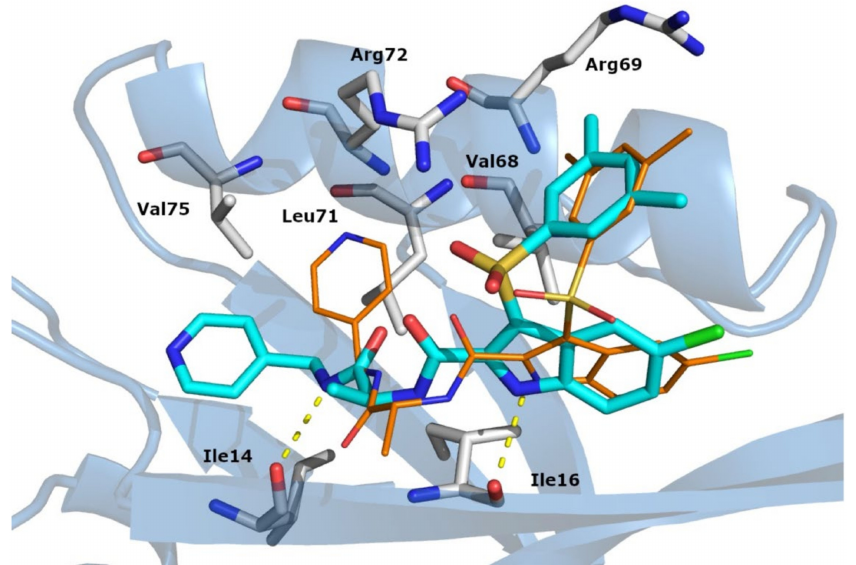
Figure 2. In silico docking results of ( S )- 1 (cyan) and ( R )- 1 (orange) in complex with the DVL1 PDZ binding site. Residues involved in interactions are reported as white sticks. The PDZ is depicted as light blue cartoon. H-bonds are reported as yellow dotted